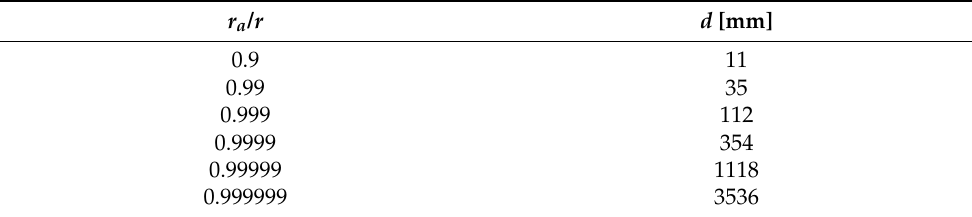
Table 4. Determination of the required distance from the sample axis to ensure a given ratio of the apparent radius to the real radius for the sample radius of 5 mm.